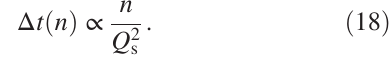
by s toward the resonance tune Q x; . m r ð t Þ at instant t and shrunk sep ð T Þ by Δ X s sep s